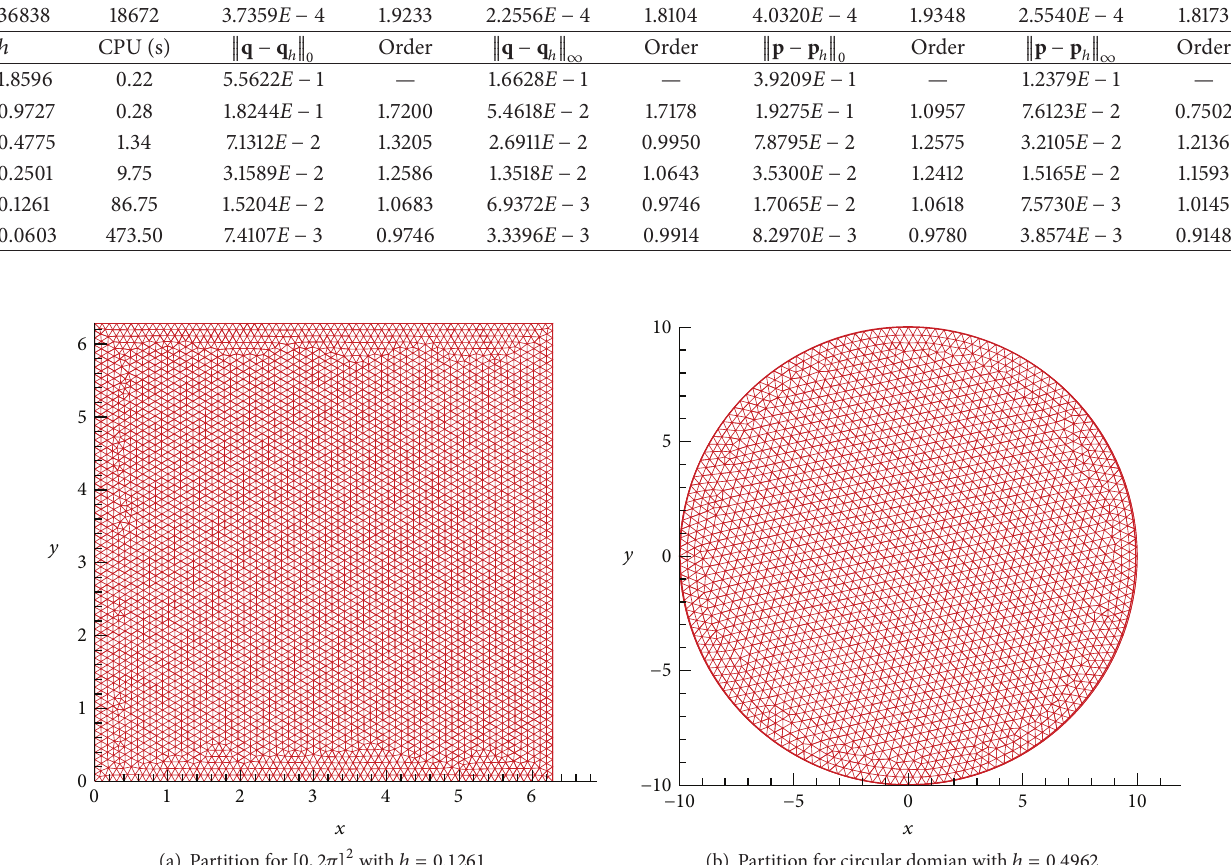
Figure 2: Delaunay partitions for square domain in Example 2 (a) and circular domain in Example 4 (b).